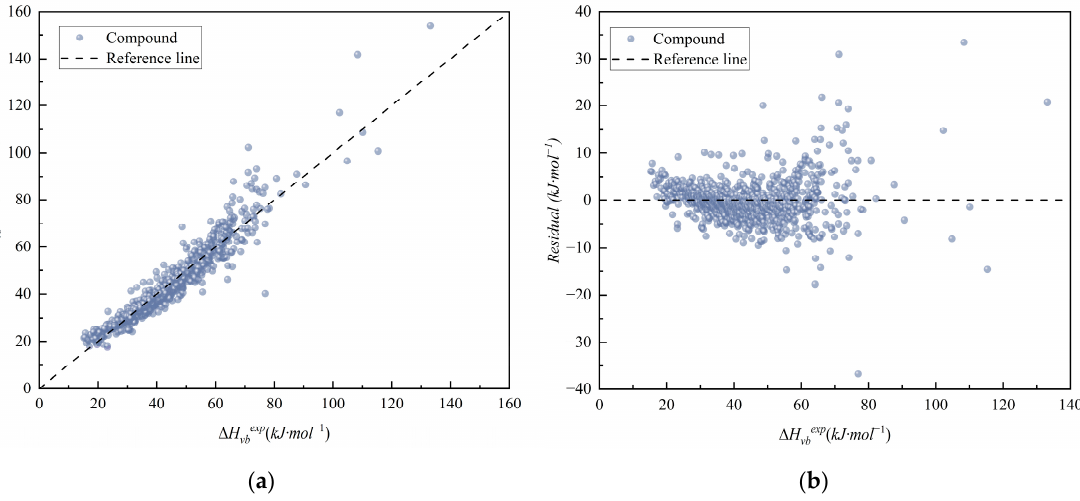
Figure 3. Comparison of predicted and experimental enthalpies of evaporation for participation in regression. ( a ) The comparison between the predicted value to the reference value; ( b ) the difference between the predicted and reference versus the reference value.